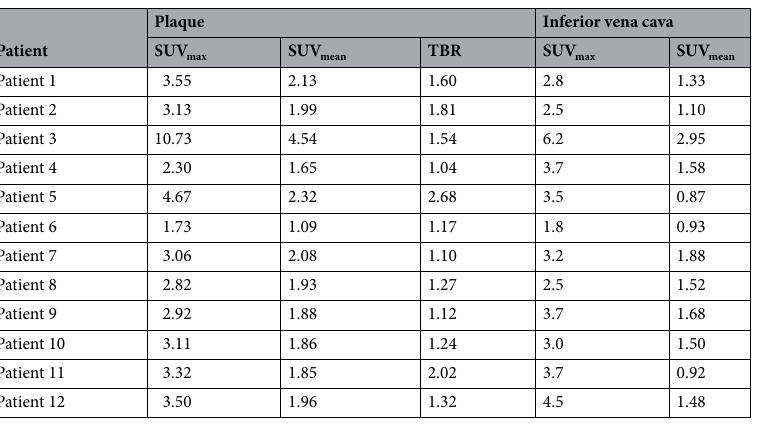
Table 2. Intraplaque 18 Fluorodeoxyglucose uptake and target-to-blood pool ratios. The plaque TBR expresses local 18 Fluorodeoxyglucose uptake in relation to SUV mean in the rest of the blood pool. TBR is calculated according to the method presented by Rudd 2007 and Metha 2012. First the mean SUV value for the entire plaque was calculated based on assessment of SUV in each region of interest (ROI) in each plaque slice. Then the mean SUV for the blood pool was calculated based on SUV from six points in the venous blood pool. Finally, TBR was calculated as follows: TBR = (plaque SUV mean )/(venous blood pool SUV mean ). S U V standard uptake value, TBR target-to-blood pool ratio.